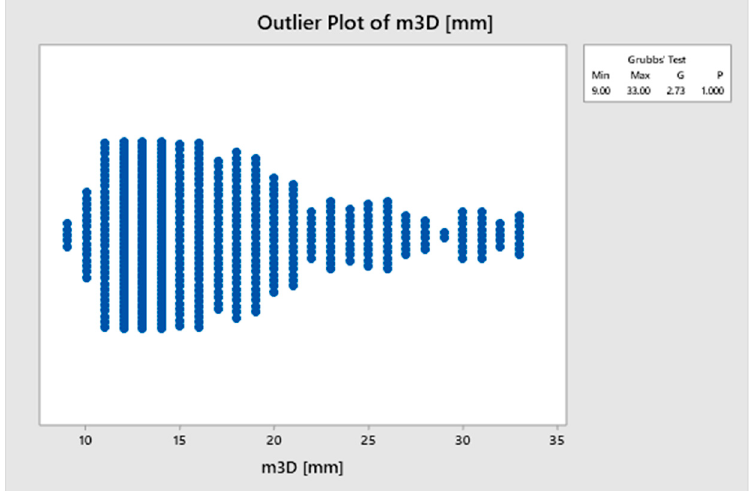
Figure 5. Grubb’s Test of Outliers.